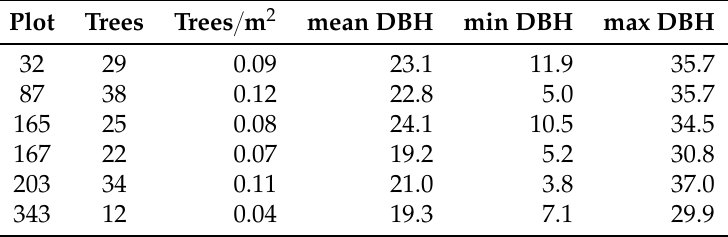
Table 1. Statistics for the processed plots. Diameter measurements in